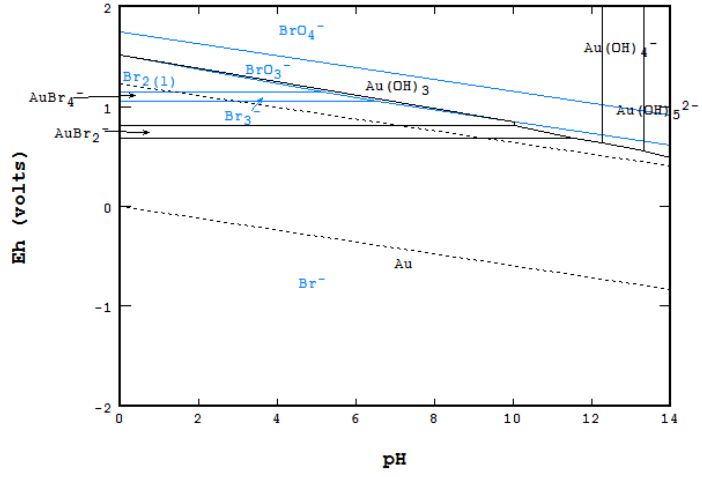
◦ C ([Au] = 10–5 M, [Br] = 0.775 M).